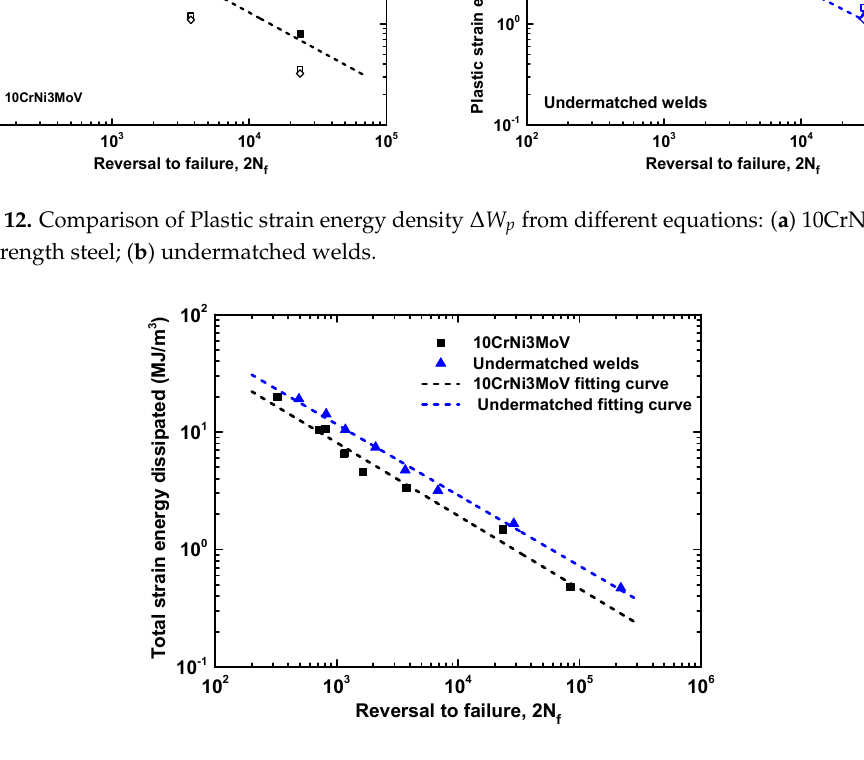
Figure 13. Comparison of total strain energy density ∆ W t between 10CrNi3MoV high strength steel and undermatched welds.